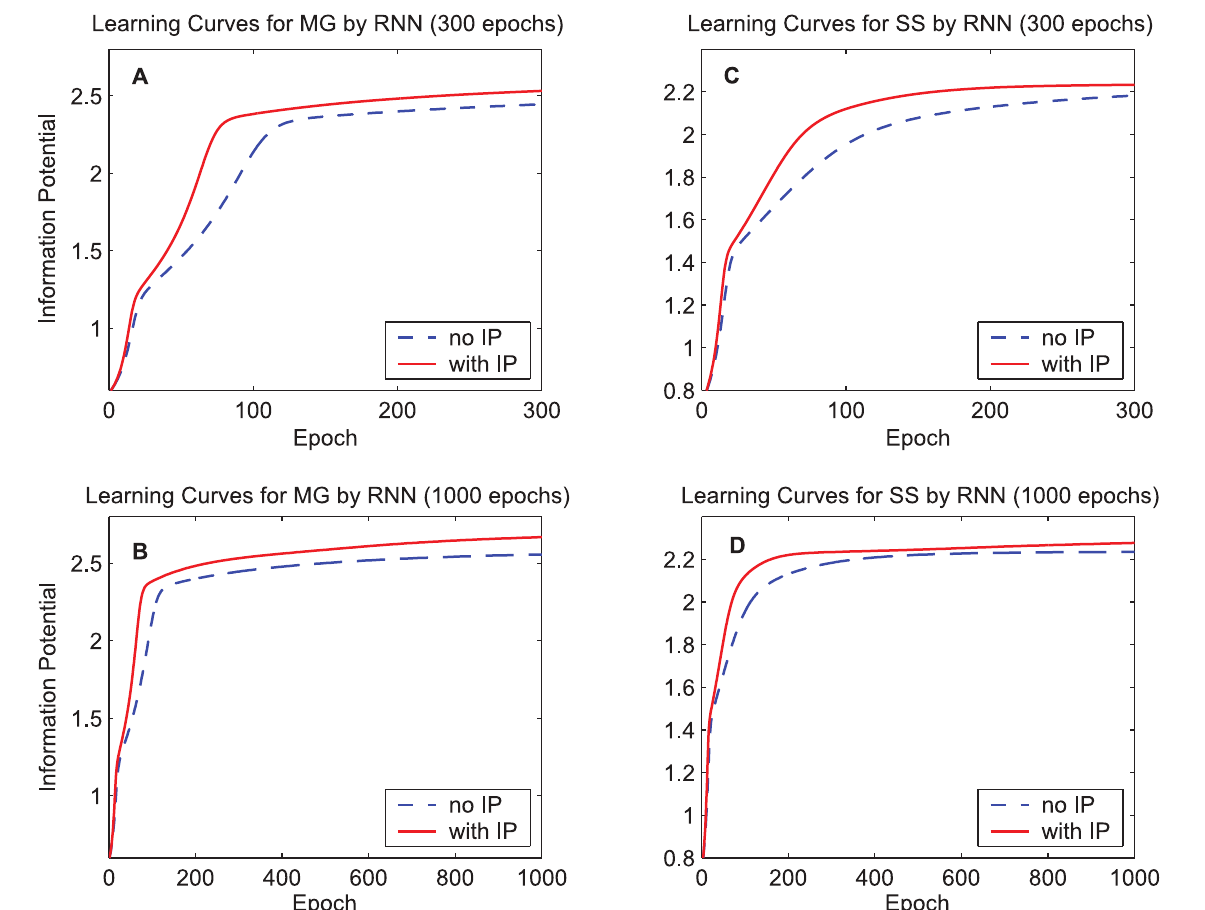
Figure 11. Learning curves of the quadratic information potential by the RNN. The dashed lines denote the learning curves of the MEE algorithm, and the solid lines denote the learning curves of the synergistic algorithm. (A) 300-epoch learning curves for the training data set ‘‘MG’’. (B) 1000-epoch learning curves of ‘‘MG’’. (C) 300-epoch learning curves for the training data set ‘‘SS’’. (D) 1000-epoch learning curves of ‘‘SS’’.